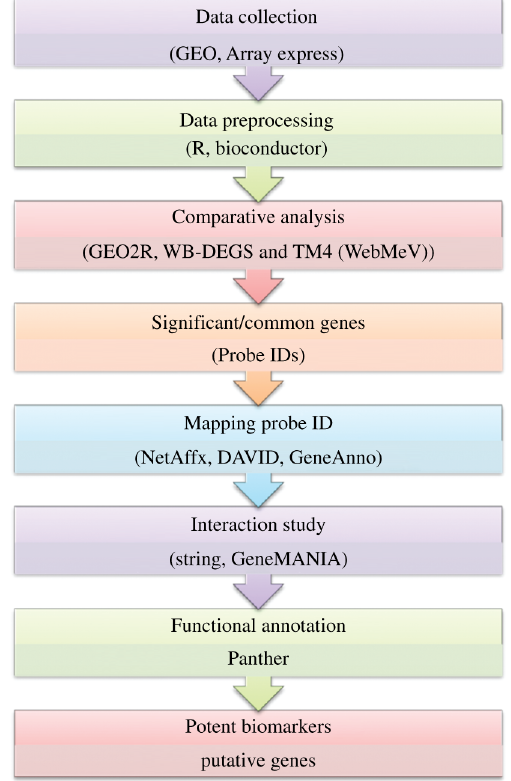
Figure 2: Flowchart of the meta-analysis performed implementing three pathways (AR, mTOR and MAPK).